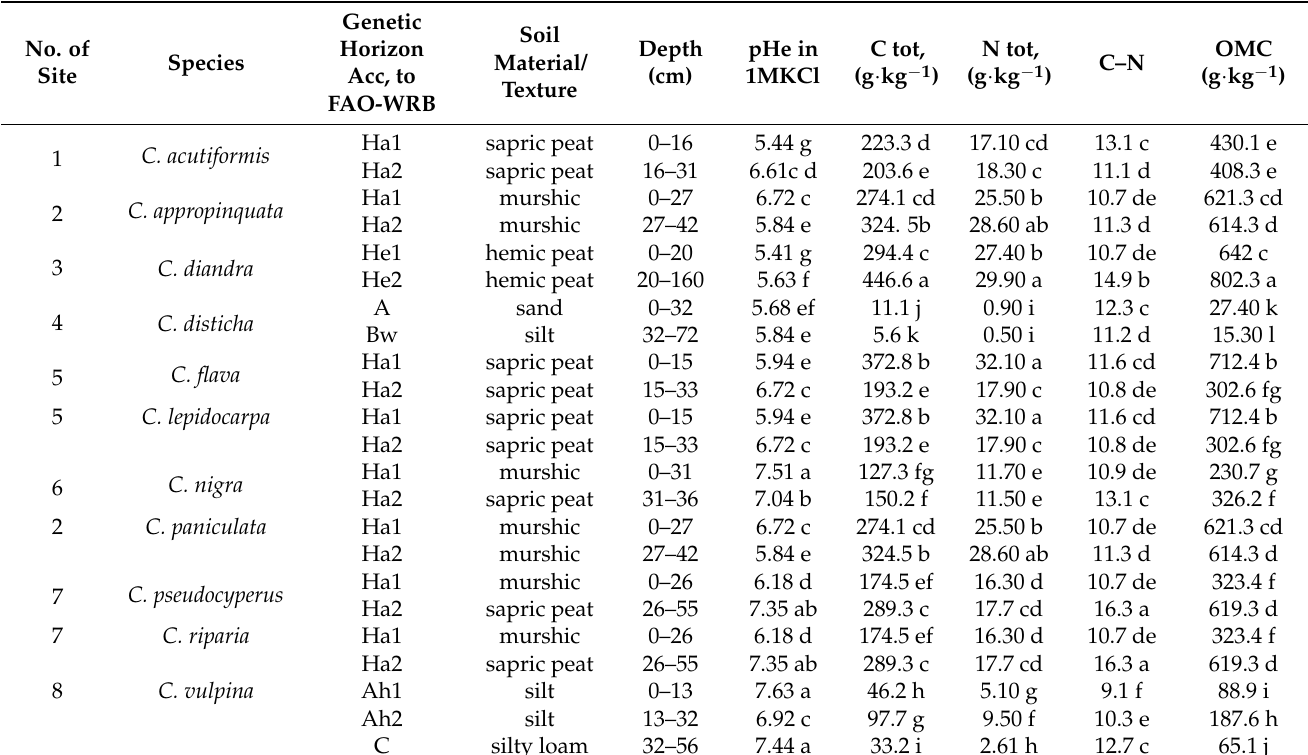
Table 1. Basic chemical properties of examined soils. The same letters indicate a lack of statistically significant differences among species analysed according to Tukey’s